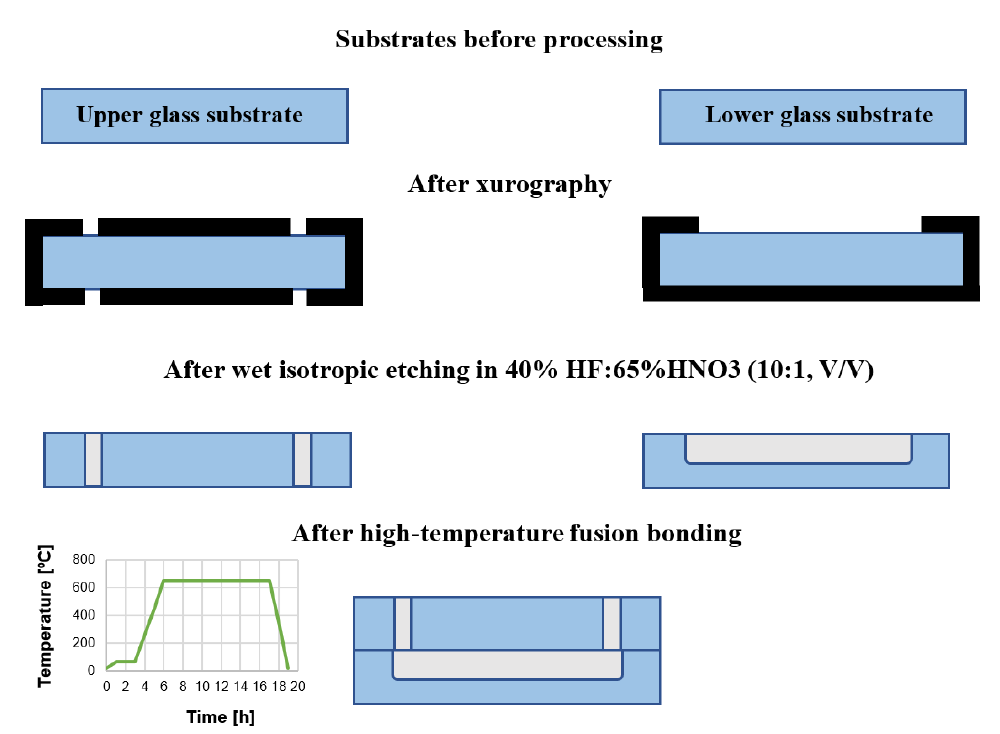
Figure 4. Fabrication of the LOCs for culturing of cancer cells—technology flow.